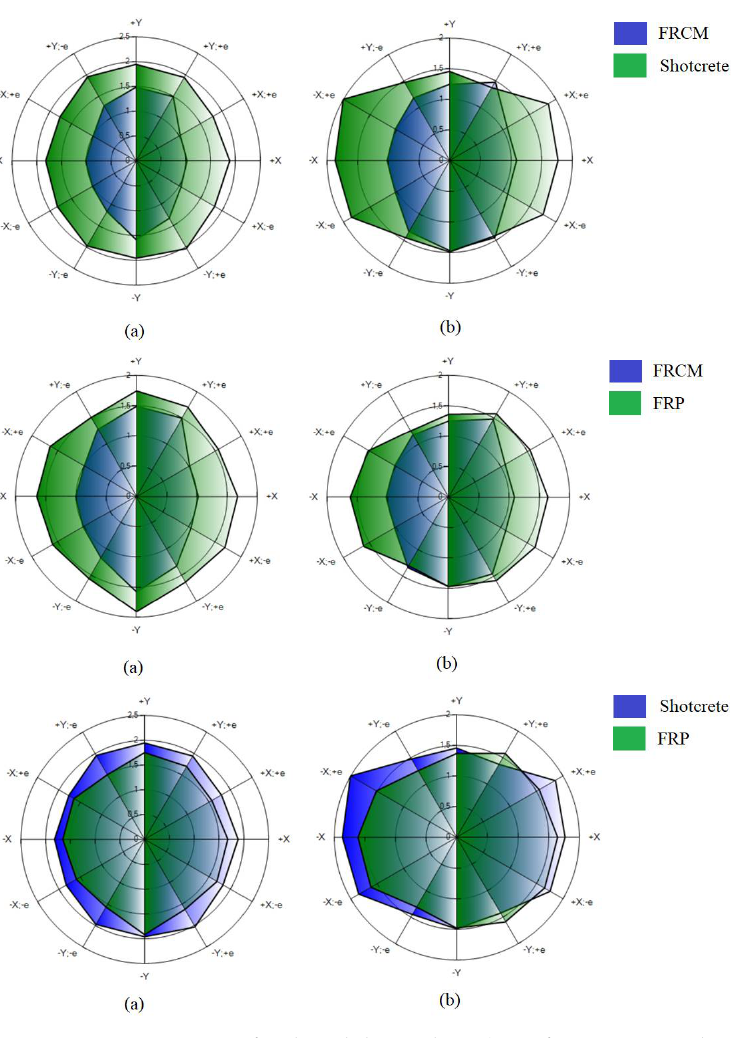
Figure 25. Comparison of vulnerability indices (Significant Damage limit state) of the different strengthening methods: ( a ) uniform load distribution; ( b ) modal load distribution.